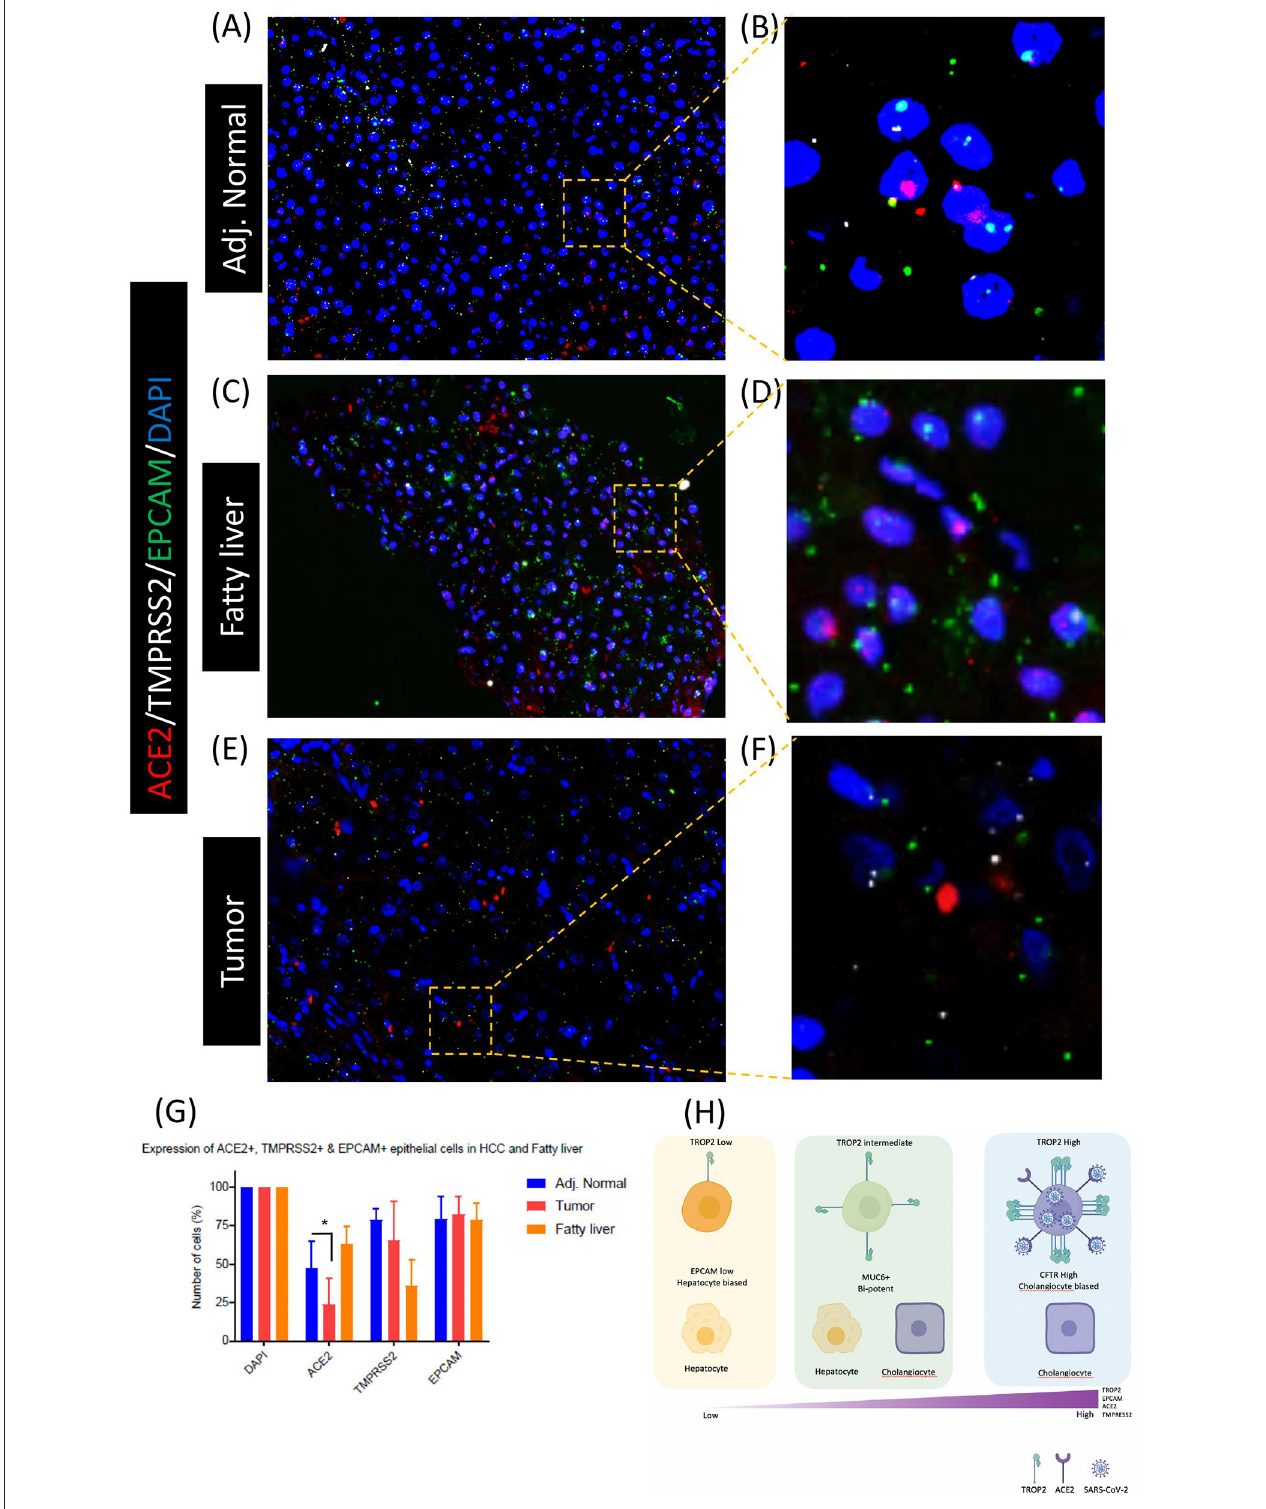
FIGURE 4 | Co-enrichment of ACE2, TMPRSS2, and EPCAM in liver epithelial cells. RNA-FISH-based detection of ACE2, TMPRSS2, and EPCAM in (A,B) adjacent normal, (C,D) fatty liver, and (E,F) tumor tissues. (G) Quantification of RNA-FISH images. (H) Schematic of TROP2 expression level and cell fate choices in adult human liver progenitor cells. TROP2 high cells express genes exhibiting cholangiocyte fate bias. TROP2 high cells also express a higher level of ACE2 and TMPRESS2, making these cells more susceptible for SARS-CoV-2 infection, indicating implications in COVID-19-associated liver dysfunctions. *means statistical significance of P < 0.05.